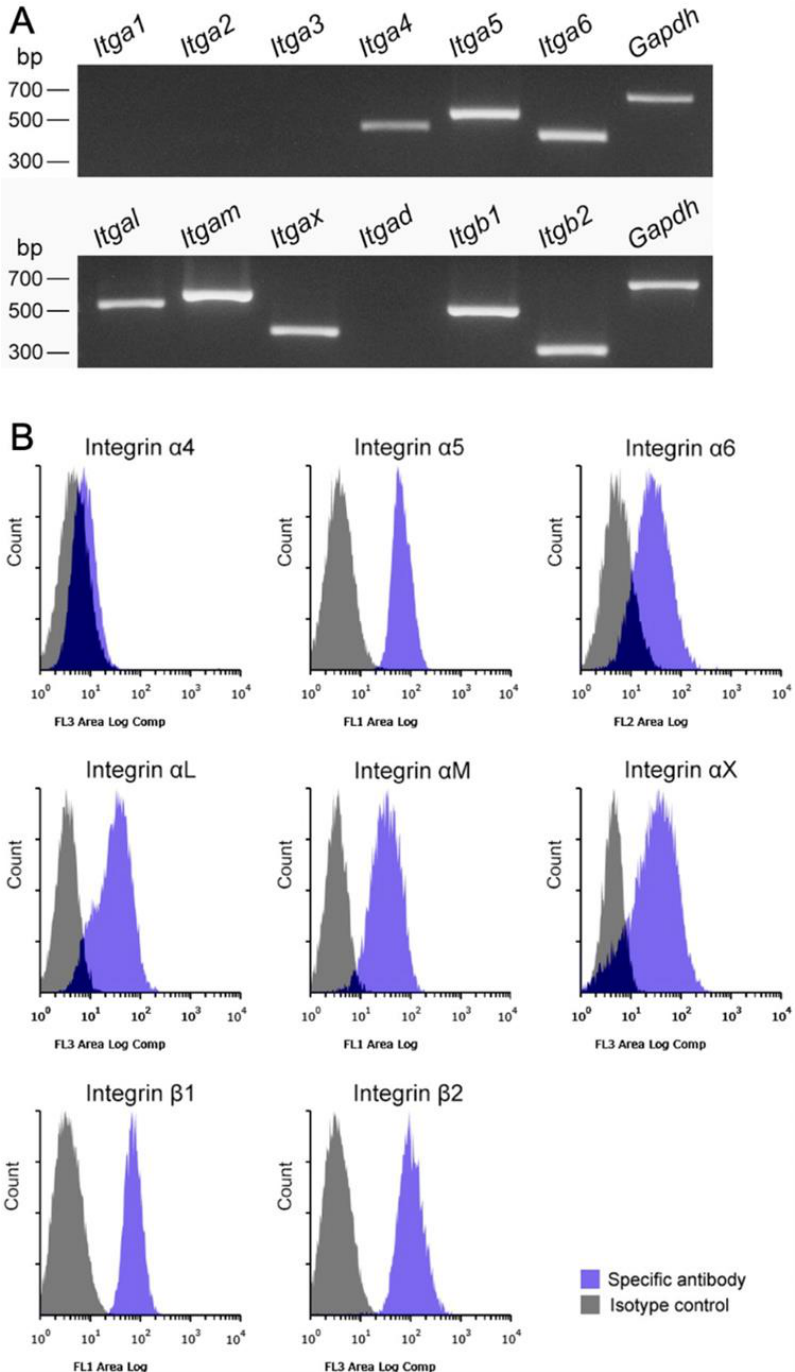
Figure 5. mRNA expression of integrin subunits and their cell surface expression in liver Mø propagated using mixed culture. ( A ) RT-PCR amplification of integrin subunits. Propagated liver Mø express Itga4 , Itga5 , Itga6 , Itgal , Itgam , Itgax , Itgb1 , and Itgb2 . ( B ) Representative histograms analyzed using flow cytometry show cell surface expression of α 4, α 5, α 6, α L, α M, α X, β 1, and β 2 integrin subunits in the liver Mø (blue histogram, specific antibody; gray histogram, isotype control). Liver Mø express relatively large amounts of α 5 β 1, α 6 β 1, α L β 2, α M β 2, and α X β 2 integrins, and substantial amounts of α 4 β 1